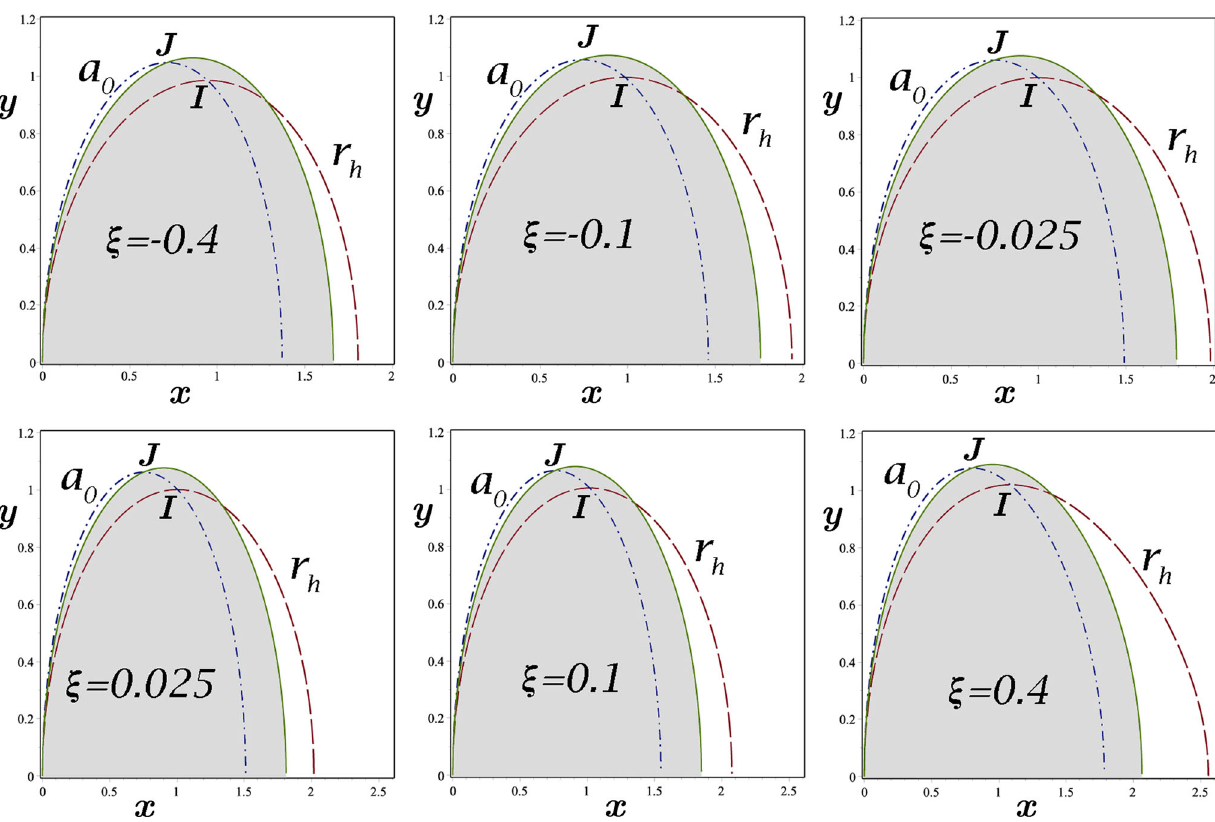
√ tively. The value of ξ = R 0 M 2 are given on each individual plot. The and y = | Q | which M M F (cid:4) points I and J marked on the curves are the intersections of the curves (blue dot-dashed curve) and M q a vs x a with q h vs x h and q v vs x a respectively. Definitions of these quantities are given in Sect.